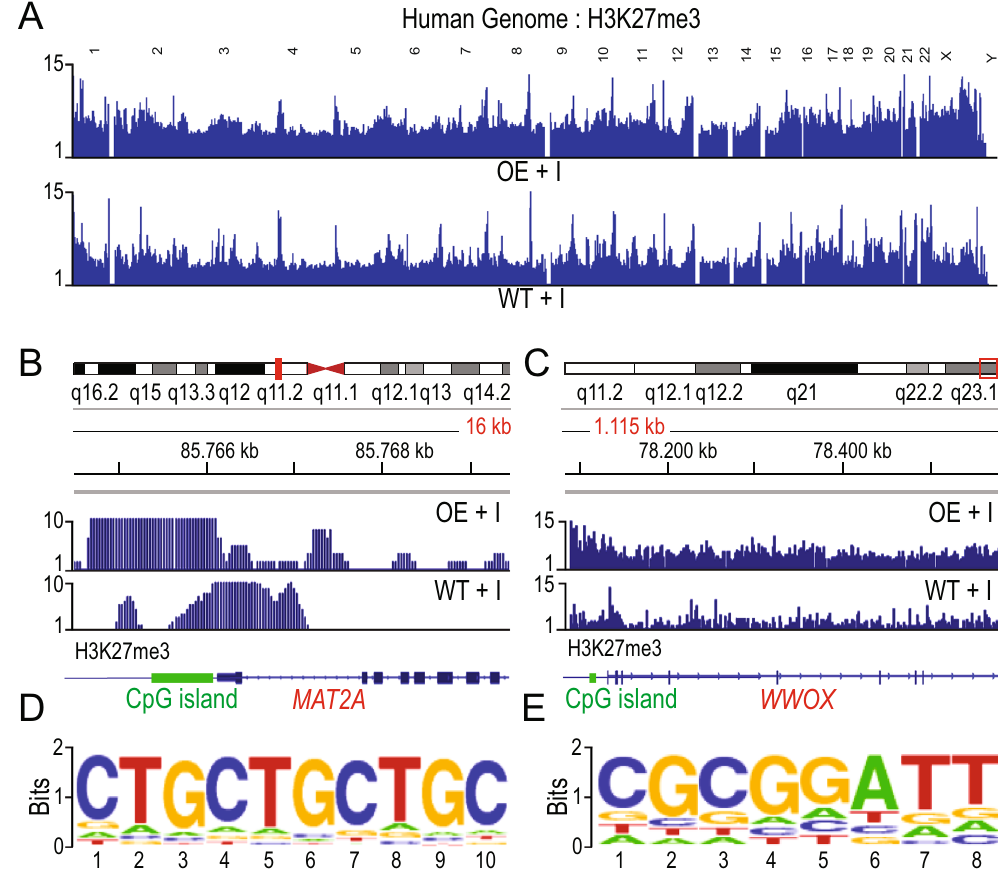
Figure 2. ( A ) Integrative Genomics Viewer screenshot (http://software.broadinstitute.org/software/igv/) of H3K27me3 ChIP-seq track peaks across the human genome (hg 19 assembly) in MDA-MB-361 cells exposed 24 hr previously to 0.025 Gy (WT + I, lower) and over-expressing PARTICLE (OE + I, upper). Chromosomal numbers are displayed. ( B,C ) Chromosomal location (red rectangle; top) and integrated genomics viewer screenshots for ChIP-seq data of OE + I (upper) and WT + I (lower). Genomic regions displayed represent MAT2A ( B ) and WWOX ( C ) loci plus 1.5 kb and 50 kb upstream respectively. Y-axis indicates the read per million (RPM) height of the ChIP-seq readout. CpG island in MAT2A (Chr. 2: 85765695–85766983) and WWOX (Chr. 16: 78133076–78134066) are depicted as green boxes. ( D,E ) Consensus motif logos within WWOX in WT + I ( D ) and OE + I ( E